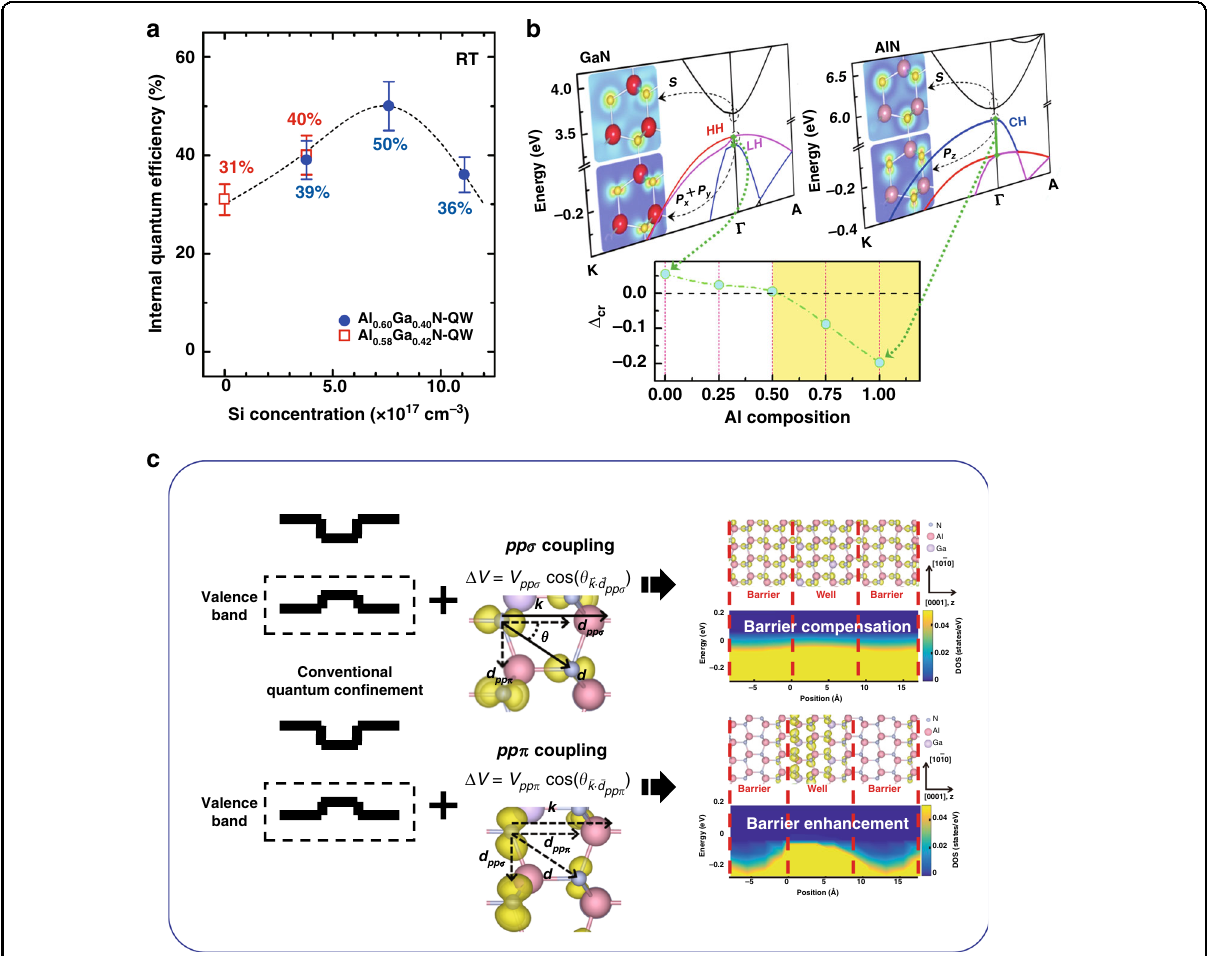
Fig. 8 The orbital con fi guration and coupling in AlGaN. a The maximum value of the IQE at 300 K obtained from Si-doped AlGaN-QWs as a function of Si concentration in the well layers. b Band structure of GaN and AlN together with the crystal fi eld splitting Δ cr as a function of Al composition of Al x Ga 1 − x N. c Schematic contribution of the pp σ and pp π coupling to the valence band offset in the conventional quantum model. Figures reproduced from a ref. 105 , © 2011 AIP Publishing, b ref. 108 , © 2013 John Wiley and Sons; c and d : ref. 113 , © 2020 Springer